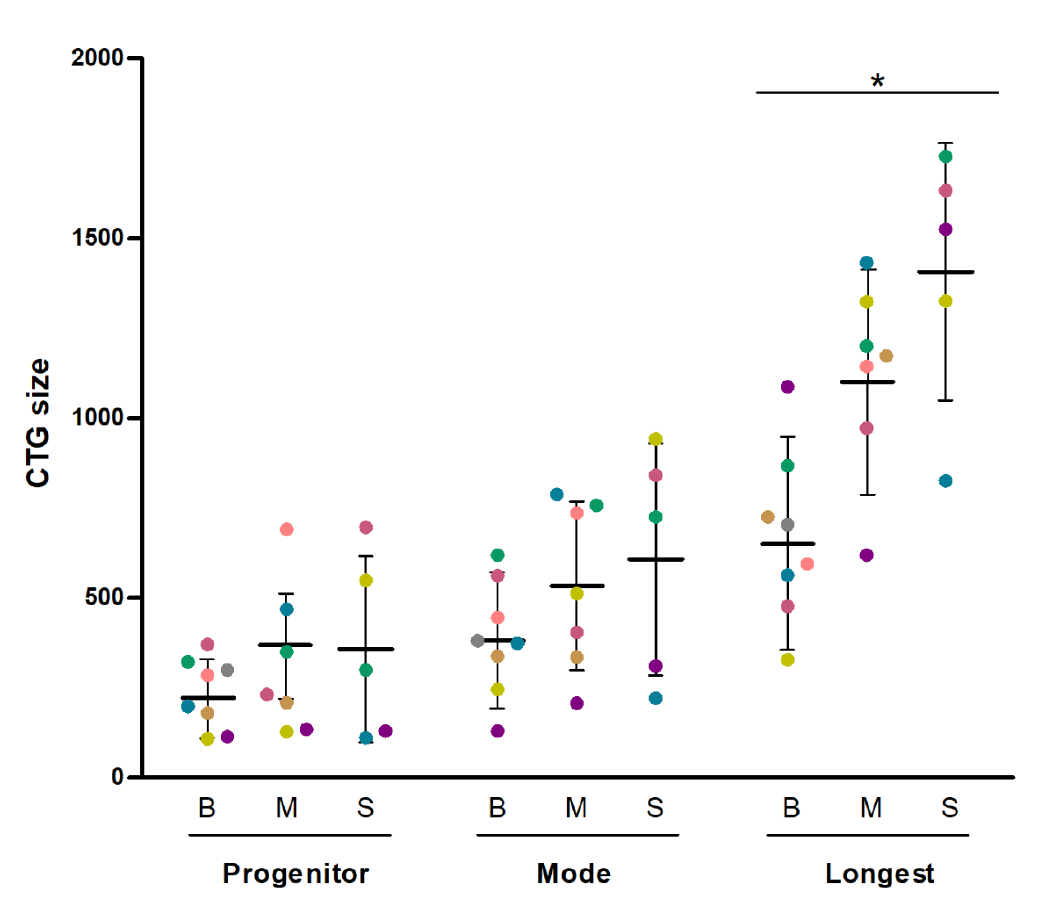
Figure 1. CTG (Cytosine-Thymine-Guanine) repeat number estimates of the progenitor, mode, and longest allele length in the study patients. All the individual CTG data are shown, with each circle representing one single CTG size (using a di ff erent color per patient). The mean and SD values of the di ff erent CTG measures are also shown. Symbol: * p = 0.041 for tissue e ff ect with repeated-measures one-factor (‘tissue’)